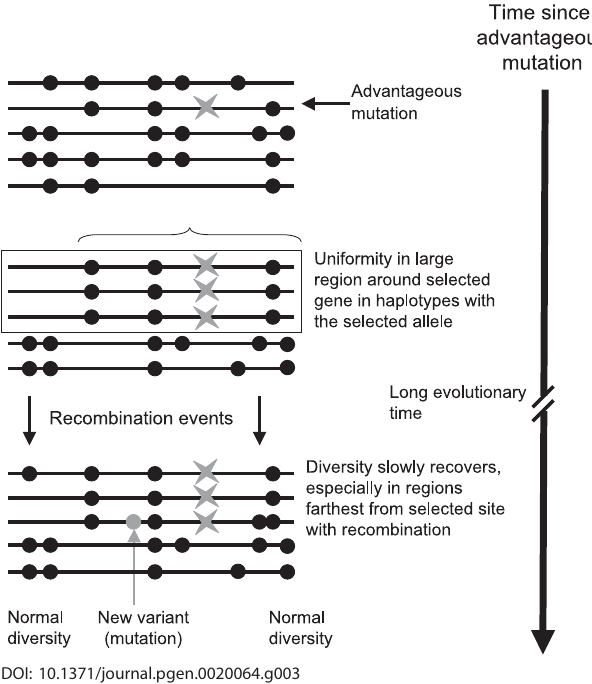
Figure 3. Haplotypes in a Genome Region after Spread of an Advantageous Mutation That Establishes a Balanced Polymorphism An advantageous mutation (denoted by the star) arises and quickly spreads to a high frequency. Variants (black dots) in the region of genome around the selected site will be carried to high frequency in the haplotypes with the mutation, and recombination subsequently introduces variants from the rest of the population, especially at sites distant from the selected site. Mutations may also occur. Note that the hitchhiking does not contribute to differentiation between haplotypes, since the variants were present before the selective